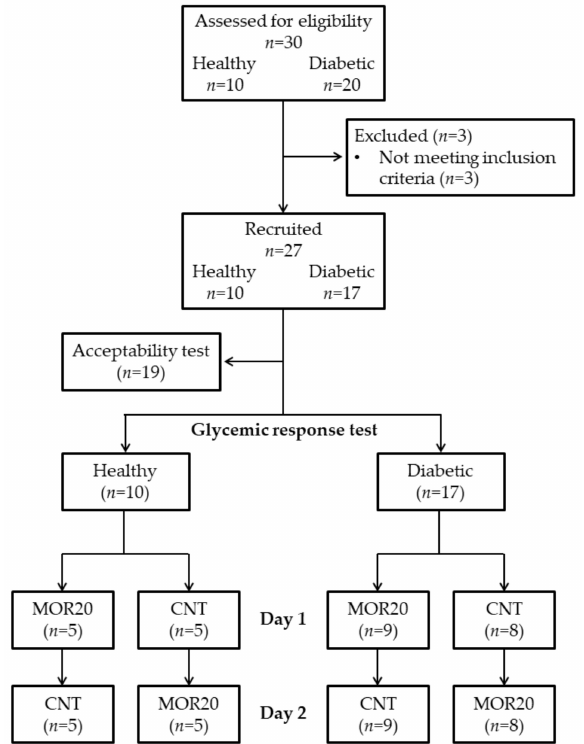
Figure 2. Flowchart of the study plan; MOR20: Meal supplemented with 20 g of Moringa oleifera leaf powder; CNT: Control